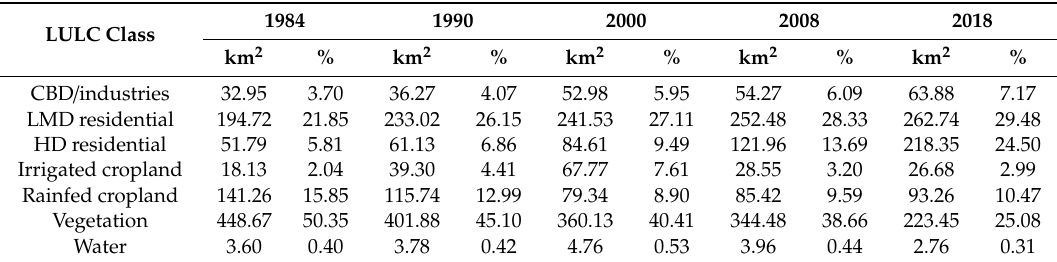
Table 3. Net change of the LULC by class area extent (km 2 ) and percentage (%) of the Harare Metropolitan Province.